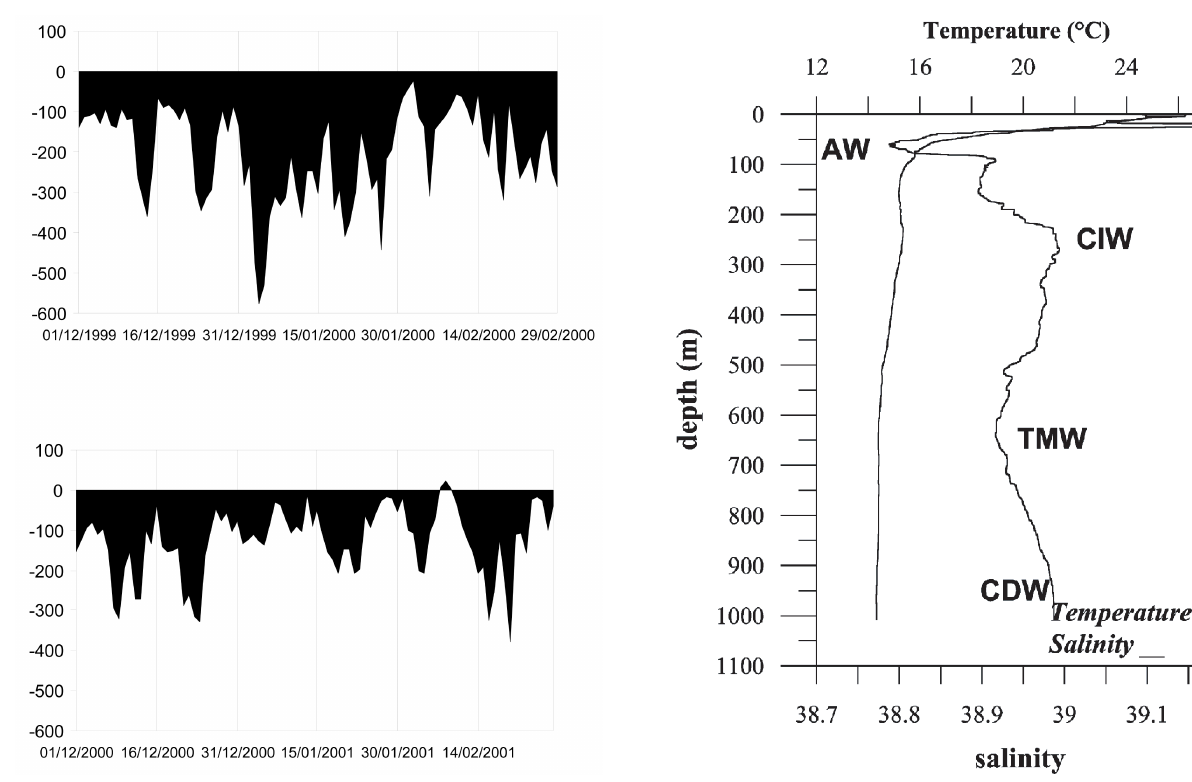
Fig. 4. Low-pass daily heat fluxes calculated from ECMWF data for the M3A buoy site for winters 99/00 and 00/01.